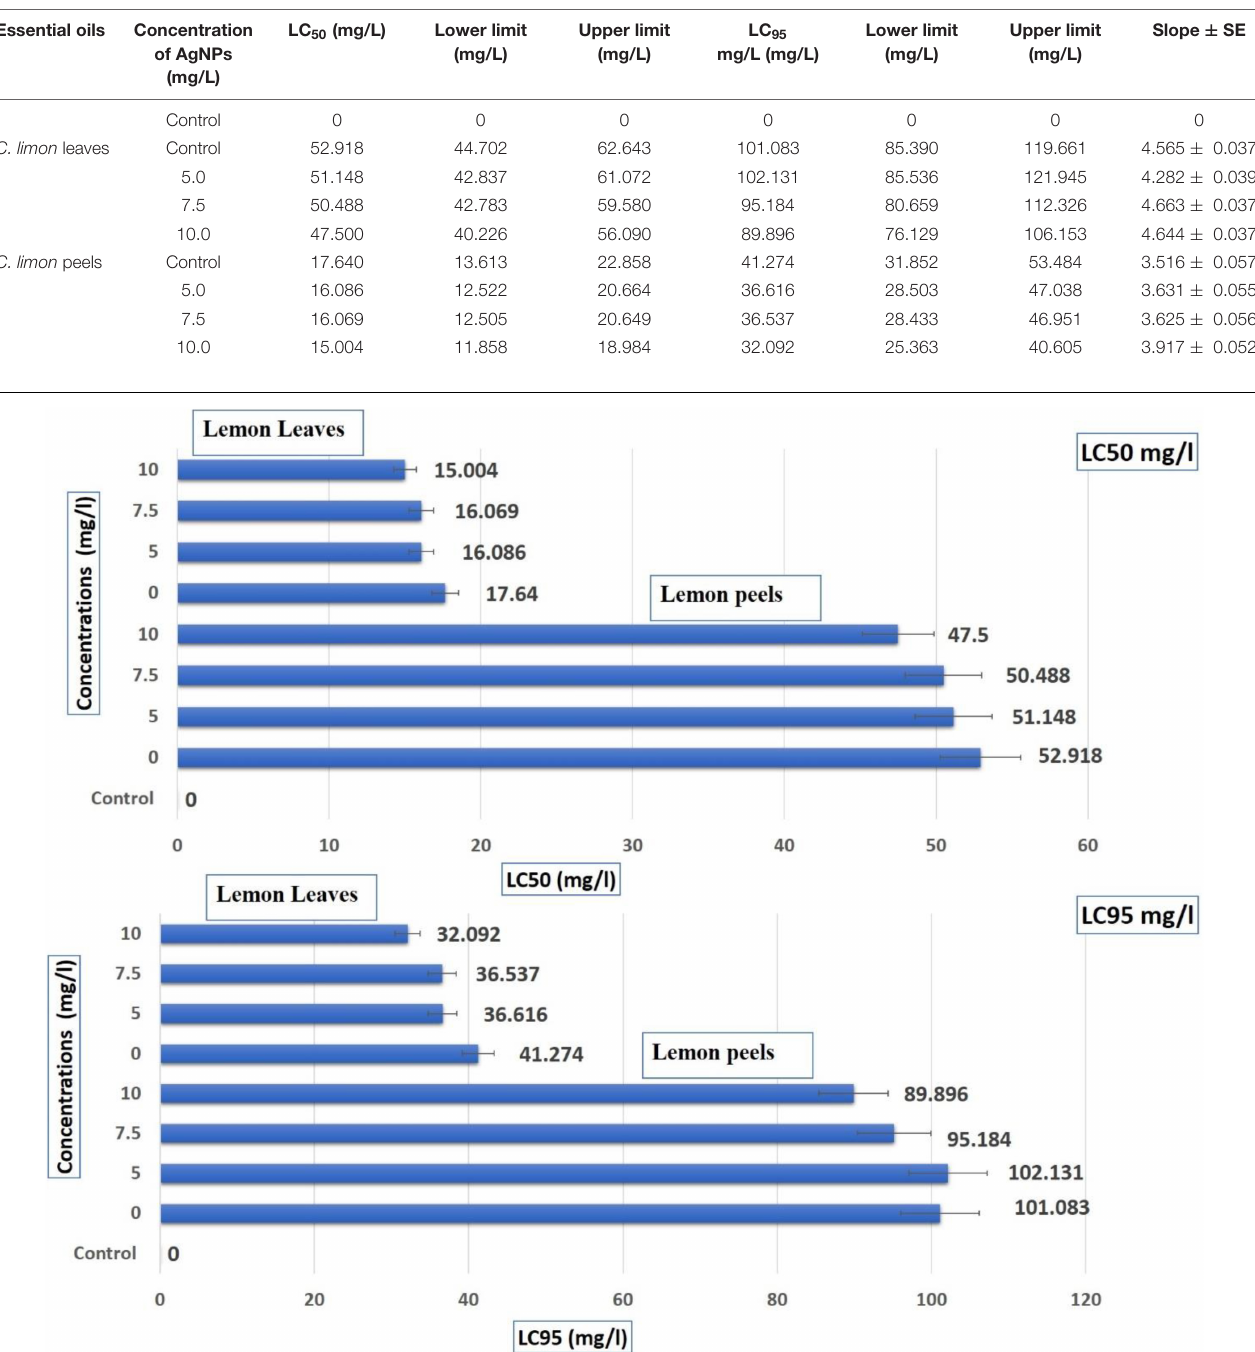
FIGURE 2 | Toxic effect (contact and residual application methods) of lemon essential oils extracted from leaves and peels treated with AgNPs at control, 5, 7.5, and 10 mg/L, against Sitophilus